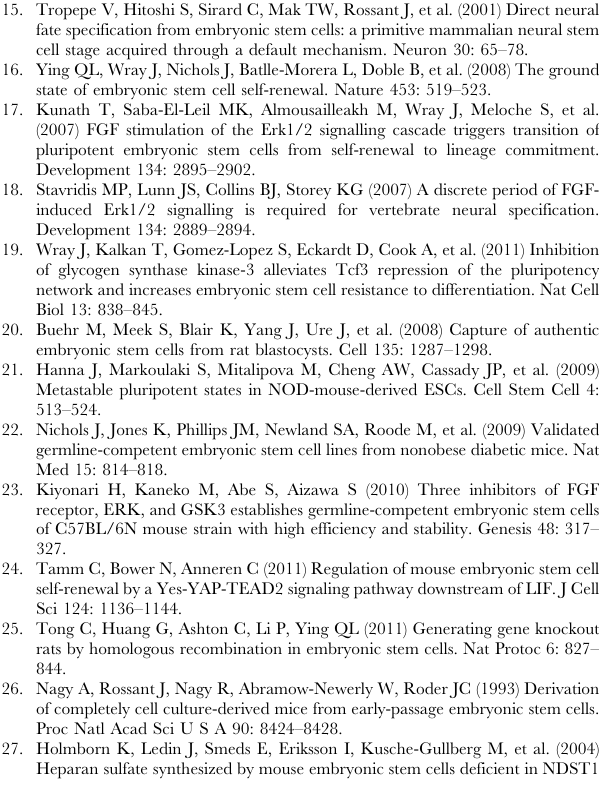
Table S1 Cost assessment of the SCM, ESN2, 2i, MEF media and lab-made N2 supplement. The table shows the costs rounded to the nearest dollar based on the list price for the United States as stated by the respective supplier, and are calculated for 500 ml of ready made media or per passage in a 10- cm cell culture dish with 10 ml media. Table S2 Summary of the investigated parameters. The table shows an overview of the obtained results for the various culturing regimes used in the present study. Since all regimes have been shown to be sufficient for adequate mES cell maintenance, being